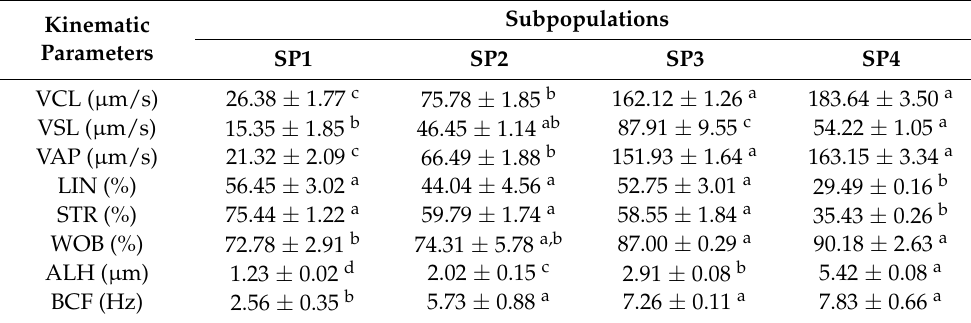
Table 1. Mean kinematic characteristics of the four motile subpopulations (SP) identified in fresh and frozen-thawed ram spermatozoa considering all incubation times in CAP and NC media (n = 12 ejaculates, 4 rams × 3